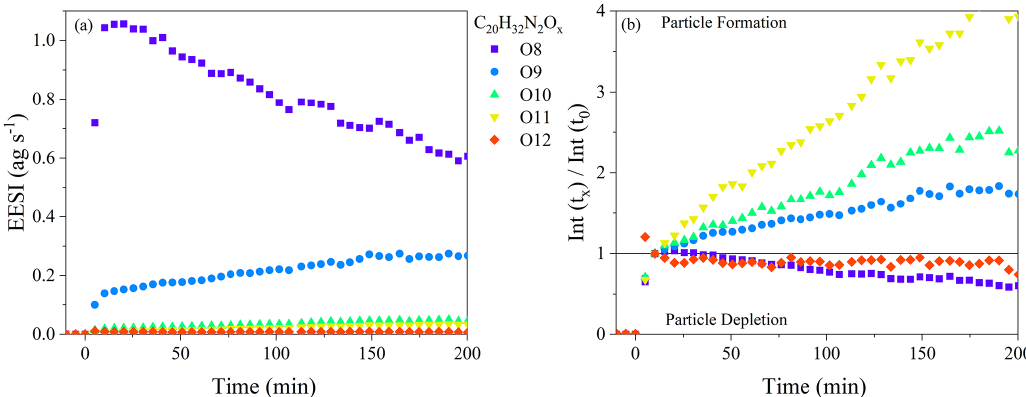
Figure 5. (a) Wall-loss-corrected time series of the C 20 H 32 N 2 O 8 − 13 molecules observed by the EESI-ToF over the course of dark aging in the chamber from Exp. 2. (b) All signals are normalized to their intensity at t =